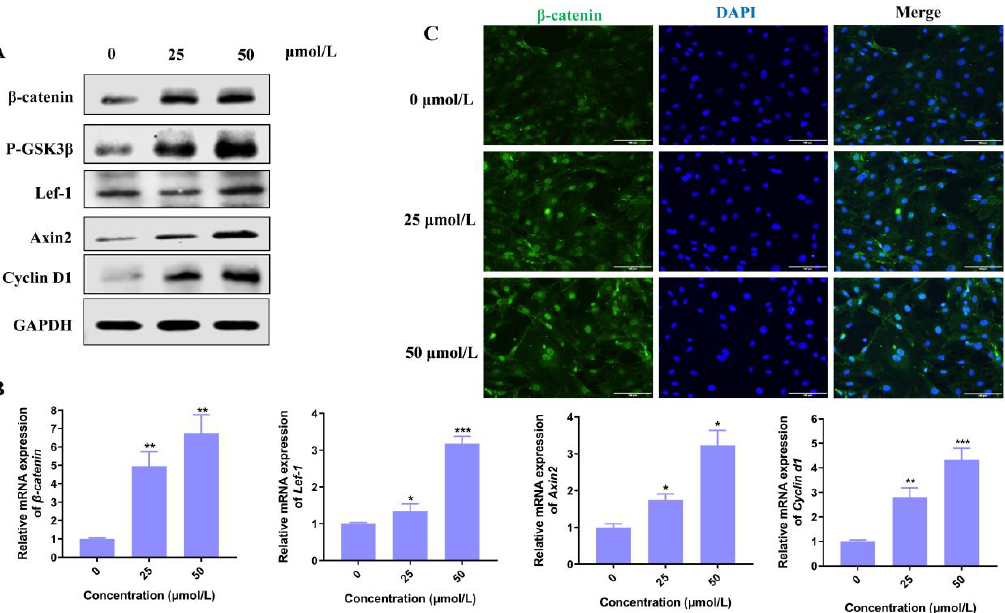
Figure 3. Hordenine activates Wnt/ β -catenin signaling pathway in the mouse primary DPCs. ( A ) Western blot analysis of β -catenin, p-GSK-3 β , Lef1, Axin2, Cyclin D1 in DPCs. ( B ) Analysis of the mRNA levels of β -catenin, Lef-1, Cyclin d1 and Axin2 in DPCs by quantitative RT-PCR. ( C ) Repre- sentative immunofluorescence images of β -catenin in DPCs treated with or without Hordenine for 24 h (Magnification, × 100; bars = 100 µ m). Data are expressed as means ± SD. * p < 0.05, ** p < 0.01, *** p < 0.001, Hordenine versus control.